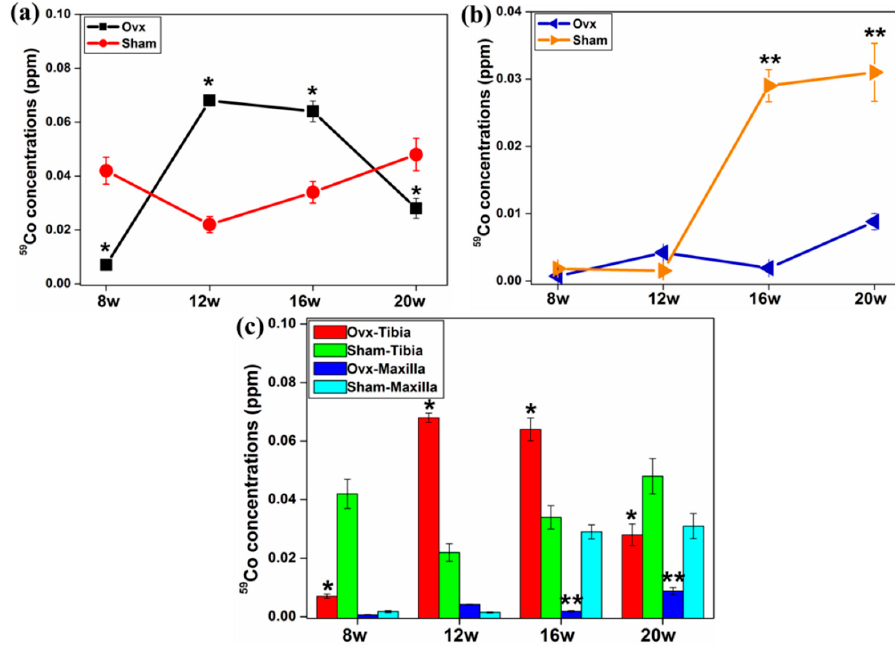
Figure 3. The average concentrations of 59 Co in tibia ( a ) and maxilla ( b ) at different time points post-surgery. ( a , b ) At 16 week, there was a higher concentration of 59 Co in both tibia and maxilla in Ovx rats compared to the sham-operated rats; and ( c ) comparison of 59 Co concentrations in tibia and maxilla over a time course post-surgery. *: Significant difference ( p < 0.05) between Ovx-tibia and Sham-tibia; **: Significant difference ( p < 0.05) between Ovx-maxilla and Sham-maxilla.